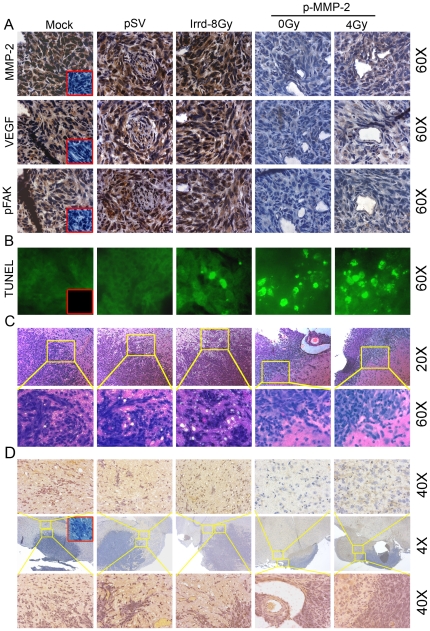
p-MMP-2 combined with radiation enhances apoptosis in vivo.
A, Immunohistochemical analysis of brain sections using anti-MMP-2, anti-VEGF and anti-pFAK antibodies. Sections were photographed (60×). Also shown is the negative control where the primary antibody was replaced by non-specific IgG (insets). B, Tissue sections of mice were evaluated with the TUNEL assay according to manufacturer's instructions and photographed under fluorescent microscopy (60×). For the negative control, samples were incubated with label solution (without terminal transferase) instead of TUNEL reaction mixture (insets). C, siRNA against MMP-2 inhibits U251 tumor cell invasion in vivo. H&E staining was performed according to standard protocol, and representative pictures of tumor sections from mock, pSV, p-MMP-2-treated mice are shown (20× and 60×). D, Immunohistochemical analysis of brain sections using anti-human nuclei (HuNu) antibody, a histological marker for identification of human cells (a specific human nuclear antigen). Entire brain sections were photographed (4×; middle row); shown on the top row is a non-tumor region (40×; top row); and shown on the bottom row is tumor and non-tumor overlapping region (40×; bottom row). Also shown is the negative control where the primary antibody was replaced by non-specific IgG (inset).